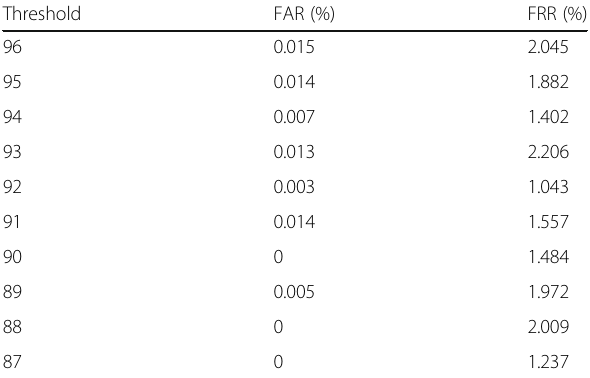
Table 1 Comparison of iris characteristics Number of groups